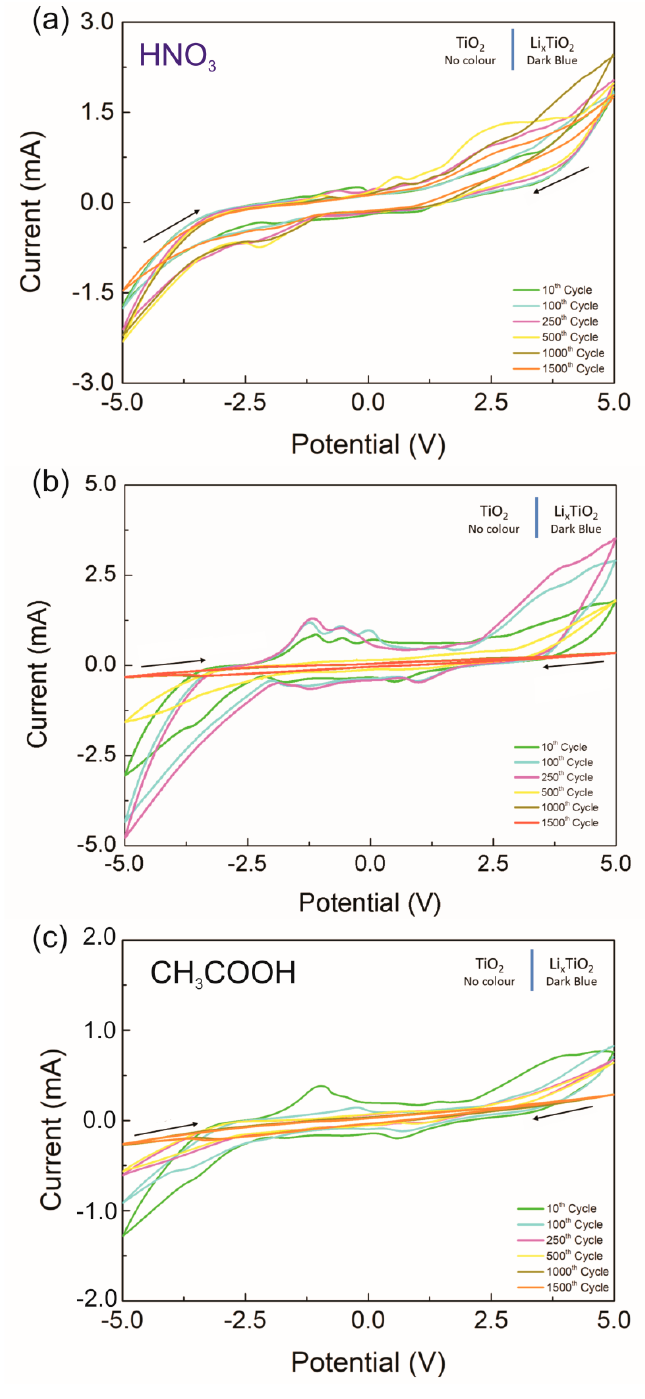
Figure 6. Cyclic voltammograms of TiO 2 nanostructured fi lms from − 5 V to 5 V (versus Ag/AgCl), at a scan rate of 500 mV/s, in a 1 M LiClO 4 –PC electrolyte, after several cycles up to a maximum of 1500. Results for the TiO 2 nanostructured films synthesized using ( a ) nitric, ( b ) hydrochloric, and ( c ) acetic acids.